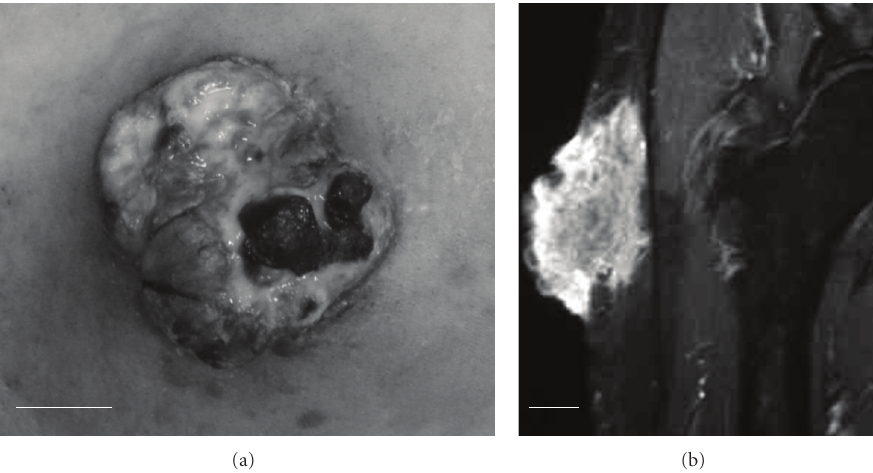
Figure 5: The tumor mass reduction induced by pre-operative RT. (a) Macroscopic findings of the tumor. (b) Coronal STIR sequence enhanced with Gd-DTPA. Bars = 2cm. The size of the tumor reduced to approximate 40% of the pre-treatment condition.